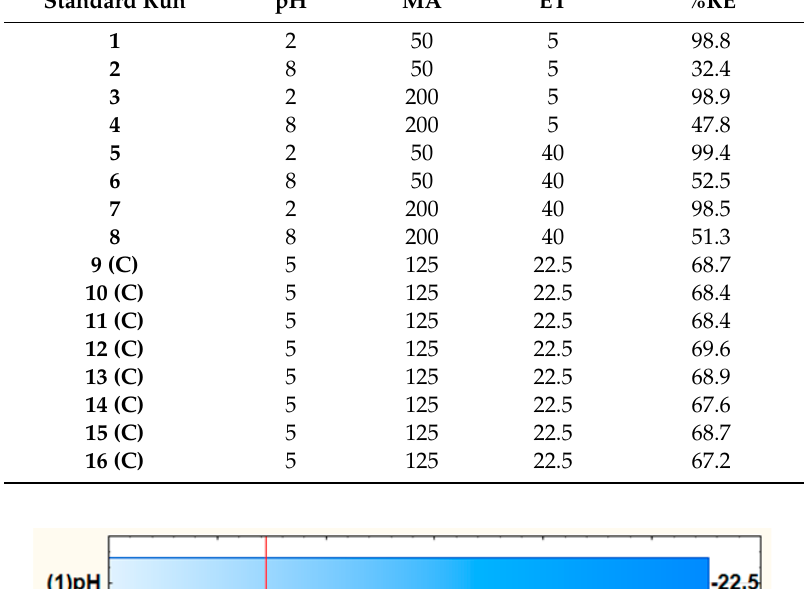
Table 1. FFD matrix of actual variable together with experimentally obtained analytical response (%RE).